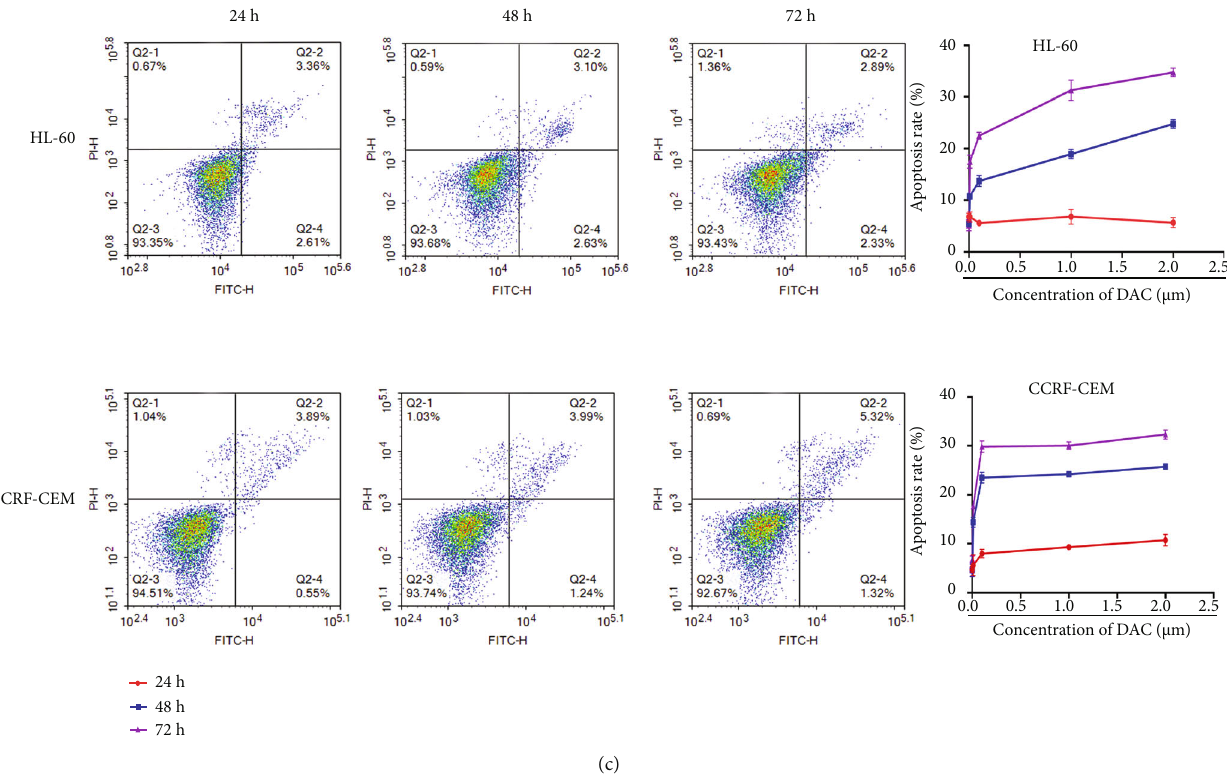
Figure 1: Selection of the optimal concentration and DAC activity duration. (a) Detection of cell proliferation in each group using CCK8. (b) qPCR detection of expression of lncRNA LINC00599. (c) Flow cytometric detection of